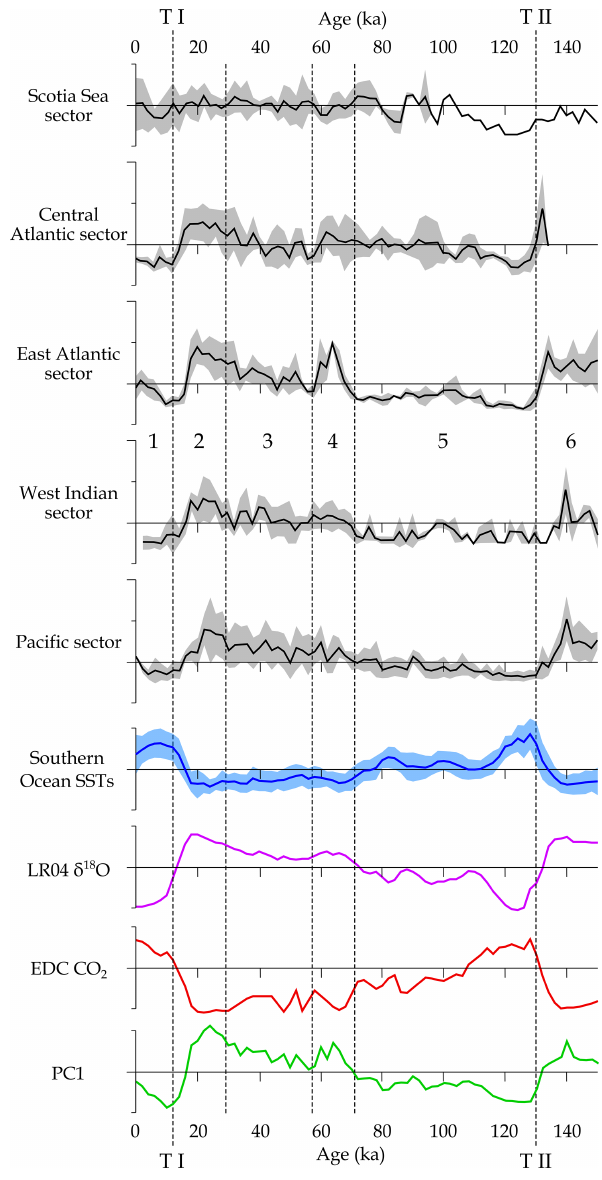
Figure 4. Comparison of the stacks of normalised sea-ice records from the five Southern Ocean sectors (black curves mark the means and grey shading marks the interquartile ranges) alongside the stack of normalised Southern Ocean sea-surface temperature (SST) records (the blue curve marks the mean and the blue shading marks the interquartile range), the normalised LR04 benthic δ 18 O stack (purple curve; Lisiecki and Raymo, 2005), the normalised atmo- spheric CO 2 record from the EDC ice core (red curve; Bazin et al., 2013a) and PC1 (green curve). The selection of the SST data is de- tailed in Sect. S1. Vertical dashed lines mark MIS boundaries, with each MIS numbered in the centre of the